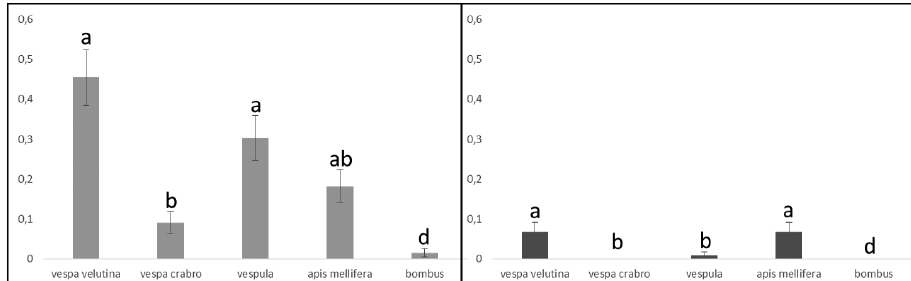
Figure 3. Average number of Hymenoptera per urns in 2015 (light grey) and 2016 (dark grey). Letters indicate the statistical differences at p=0.005 (Wilcoxon test with Bonferroni correction). Table 1. Comparison (Wilcoxon test) of relative abundances of some insect orders (Diptera, Hymenop- tera, Lepidoptera, Coleoptera and Heteroptera) trapped by Sarracenia hybrids in 2015 and 2016.